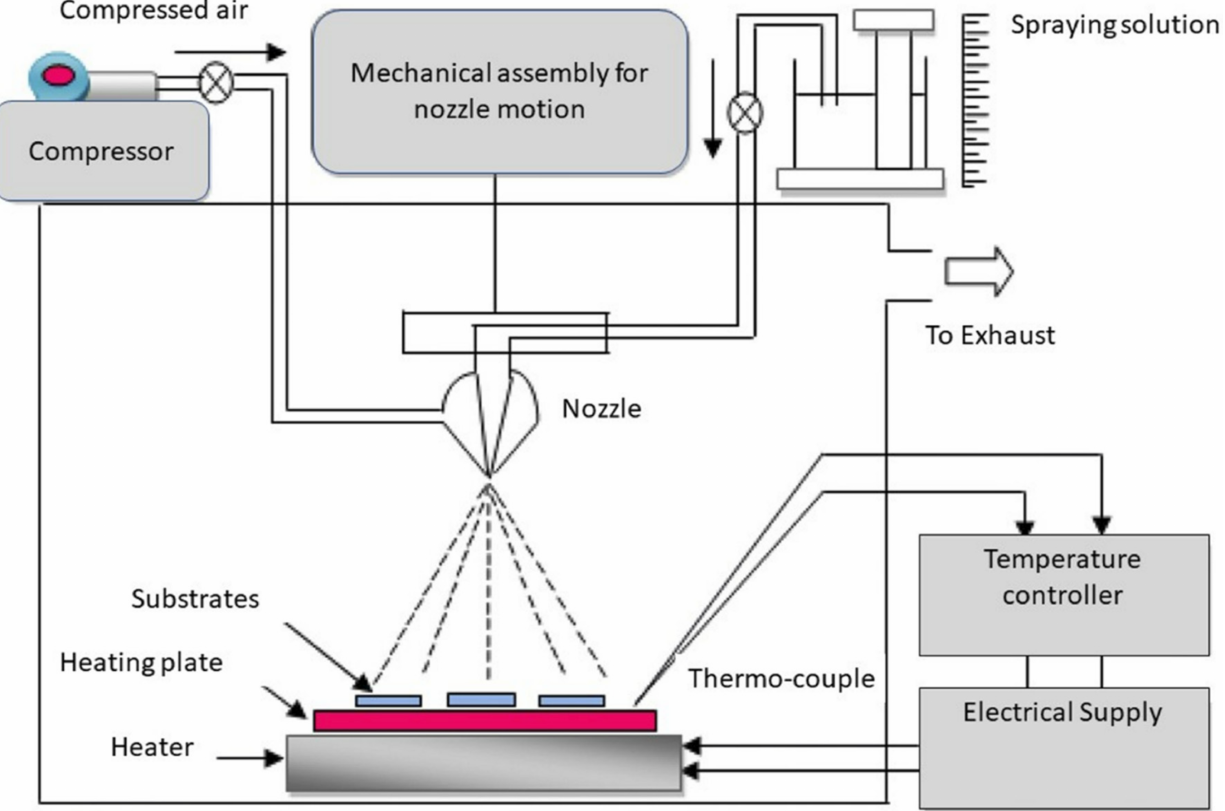
Figure 12. Schematic of spray-pyrolysis technique. Reprinted with permission from